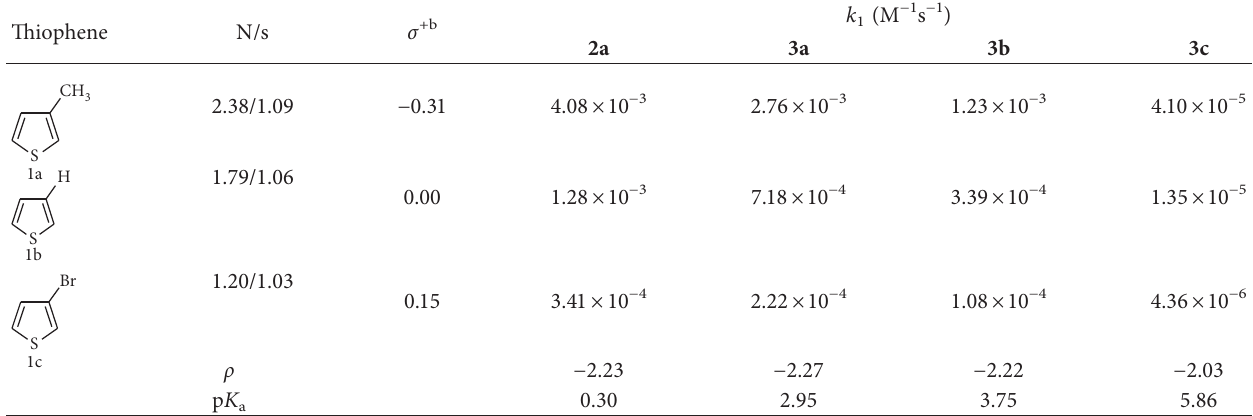
Table 2: Second-order rate constants k electrophiles 2a and 3a-c